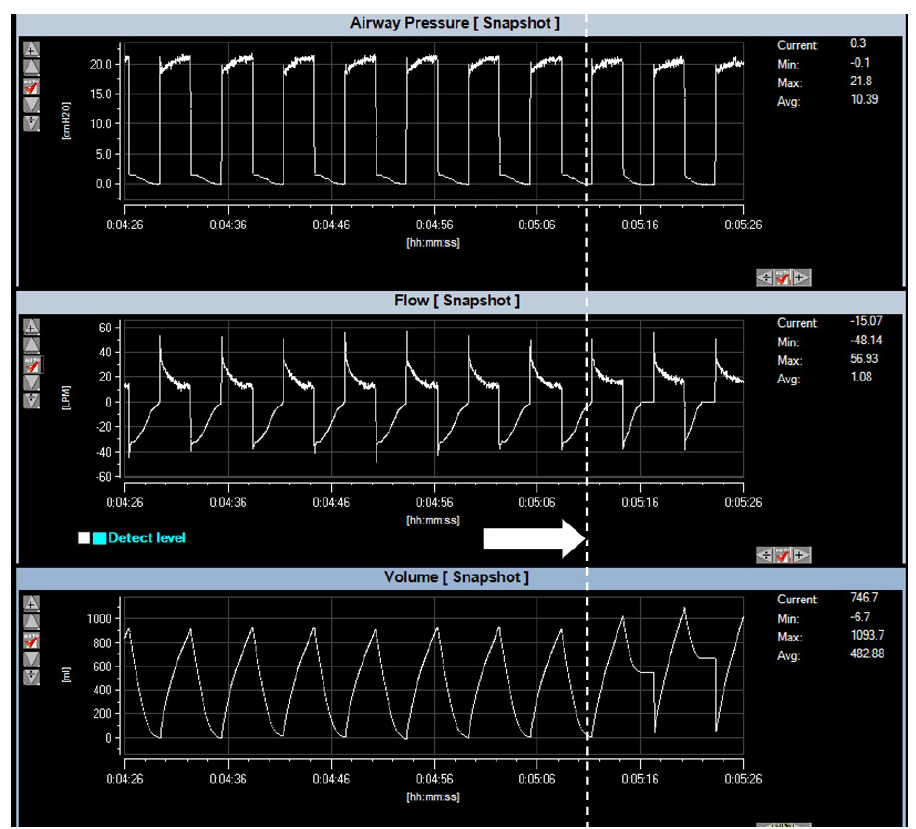
Figure 21. Performance of pressure stabilized test, using VT Plus Hi Flow Ventilator analyzer and SmartLung 2000. Setting pressure is 20 cmH 2 O, lung resistance is 20 mbar/L/s, and lung compliance is 0.025 L/mbar. Arrow indicates the opening of leakage valve. At the onset of the leakage valve, the PID control of ventilator manages to maintain constant pressure as designed.